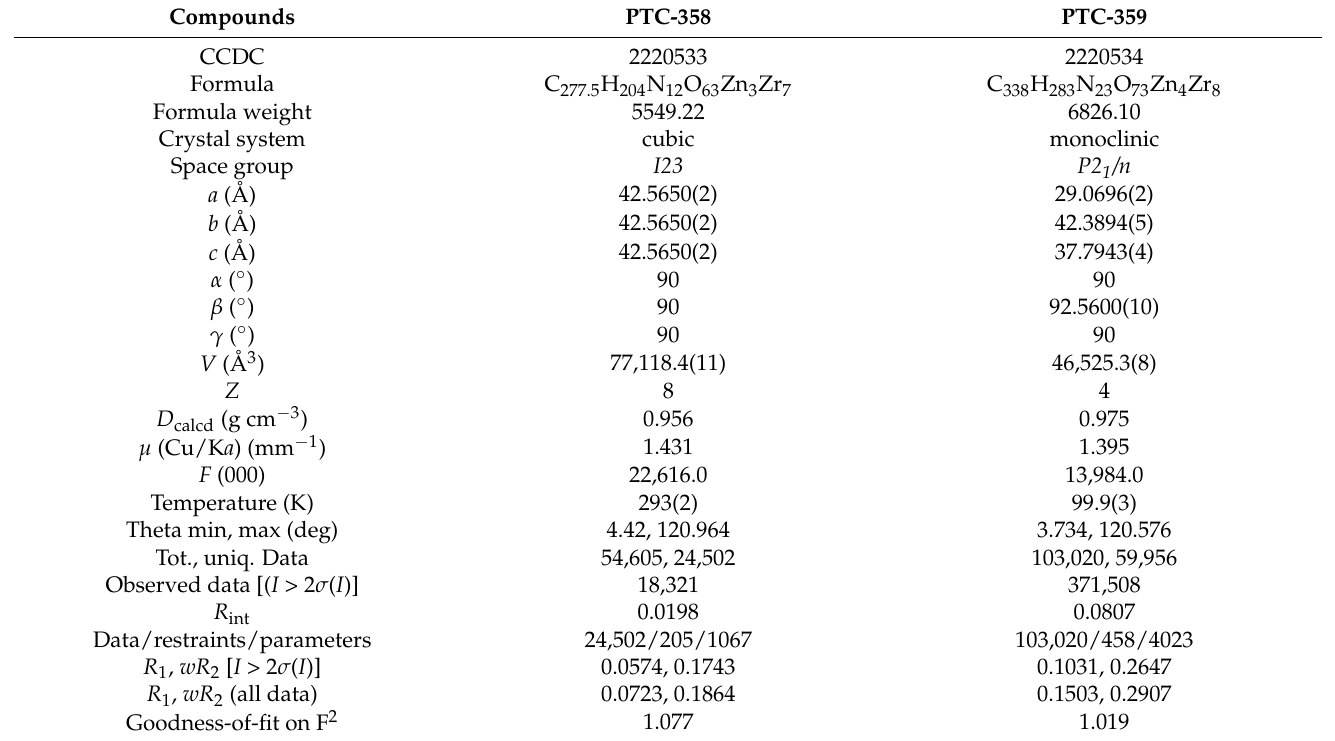
Table 2. Crystallographic Data and Structure Refinement Details for PTC-358 and PTC-359